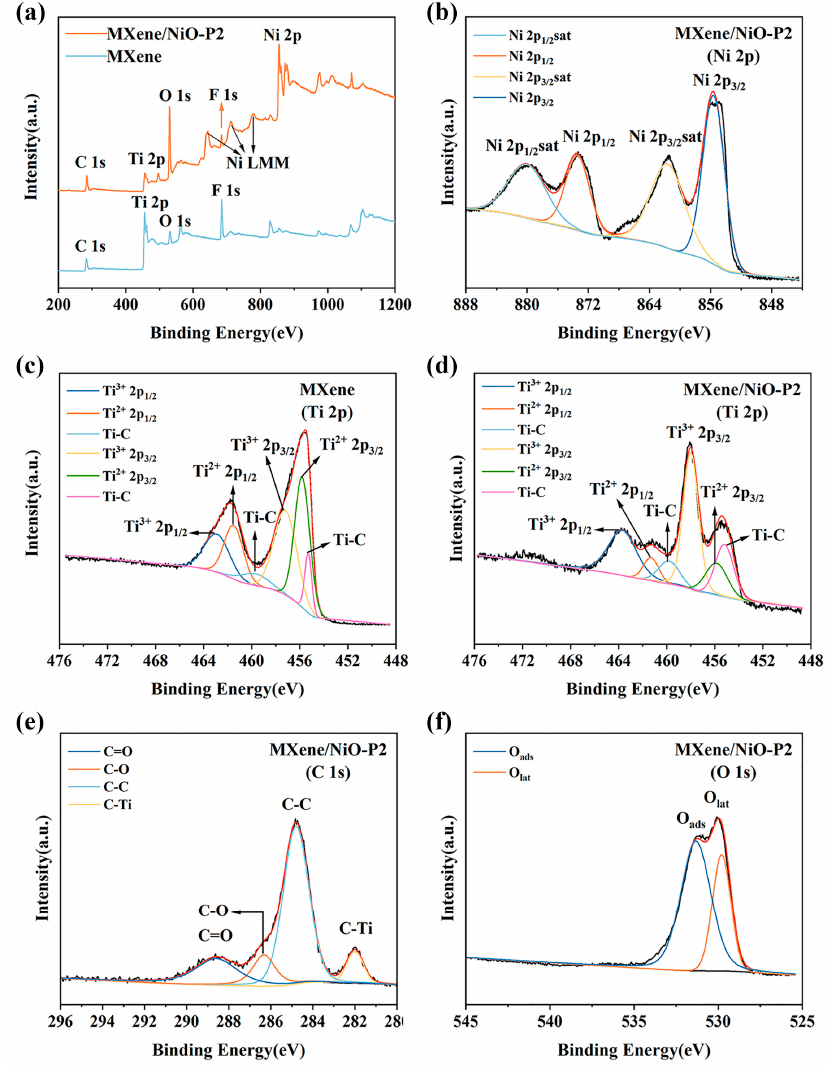
Figure 3. ( a ) The XPS survey spectra of MXene and MXene/NiO-P2; ( b ) the Ni 2p spectrum of MXene/NiO-P2; and ( c , d ) the Ti 2p spectra of MXene and MXene/NiO-P2, respectively. ( e ) The C1s spectrum and ( f ) O1s spectrum of MXene/NiO-P2.